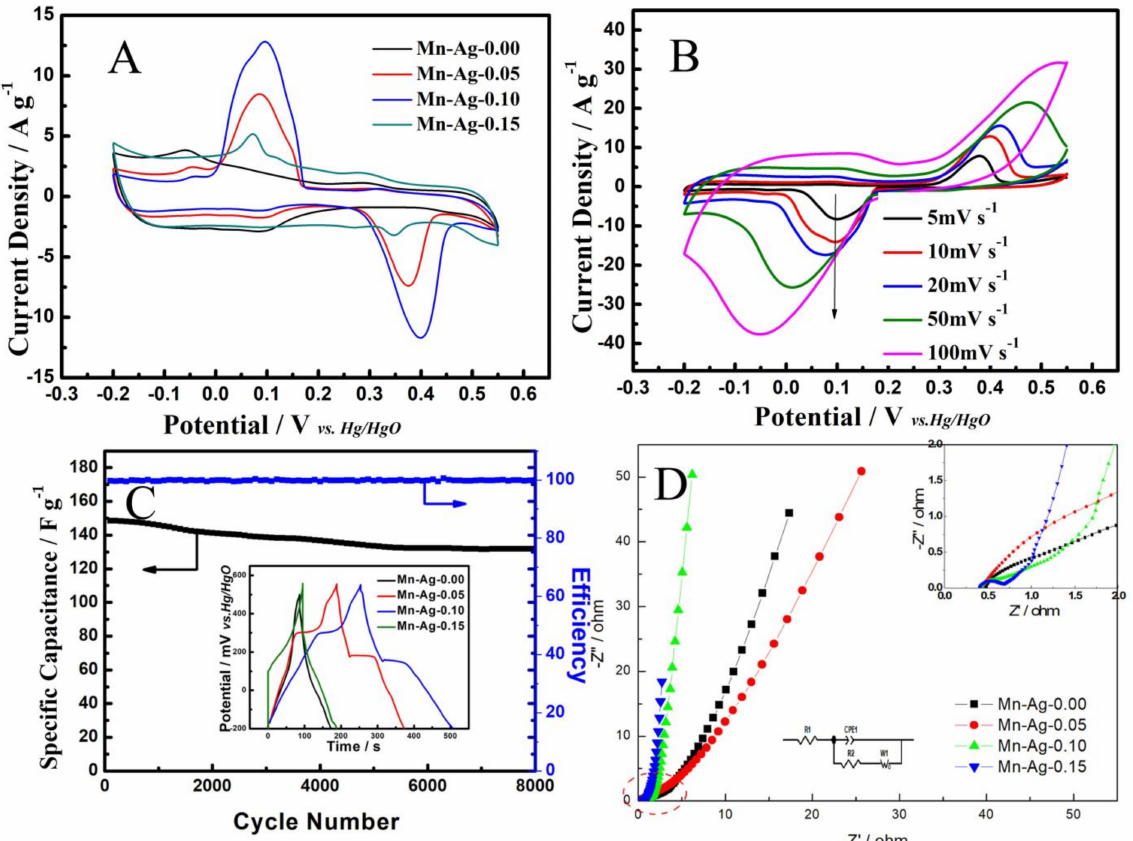
Figure 6. Electrochemical performance of synthesized samples. ( A ) CV curves at the scan rate of 10 mV s − 1 . ( B ) CV curves of Ag-Mn-0.10 at different scan rates. ( C ) Lifetime and coulombic efficiency curves of Ag-Mn-0.10 at a high current density of 10 A g − 1 . The insert in the bottom-left corner is the galvanostatic charge-discharge curves tested at 1 A g − 1 . ( D ) Nyquist plots. The insert in the top-right corner is the enlarged Nyquist plot in the high frequency